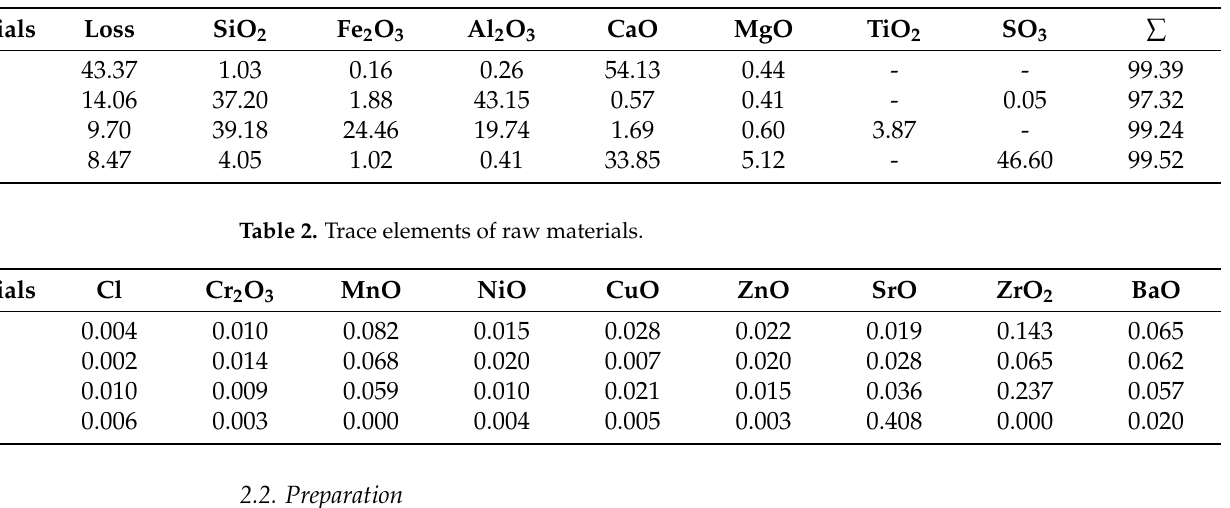
Table 1. Main chemical compositions of raw materials.